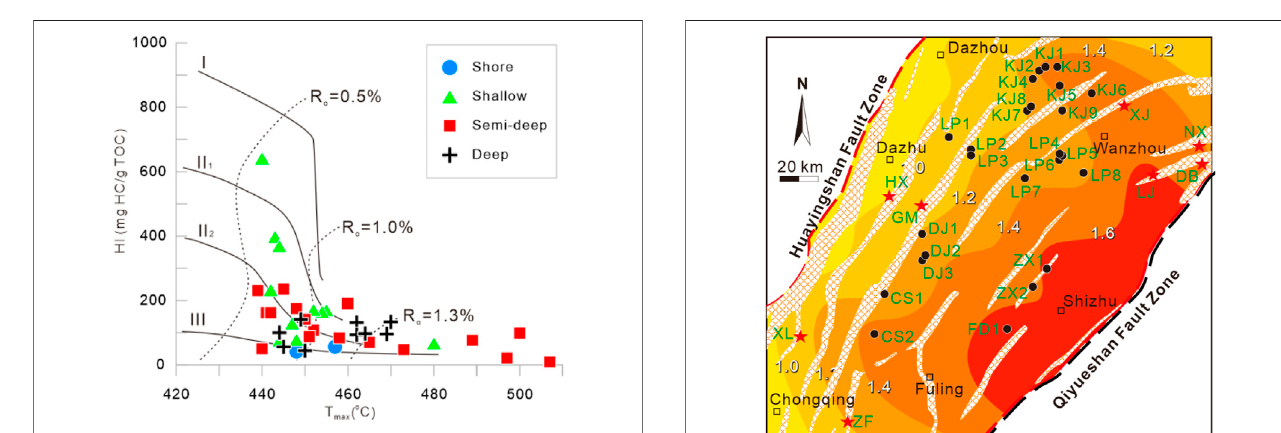
Frontiers in Earth Science |